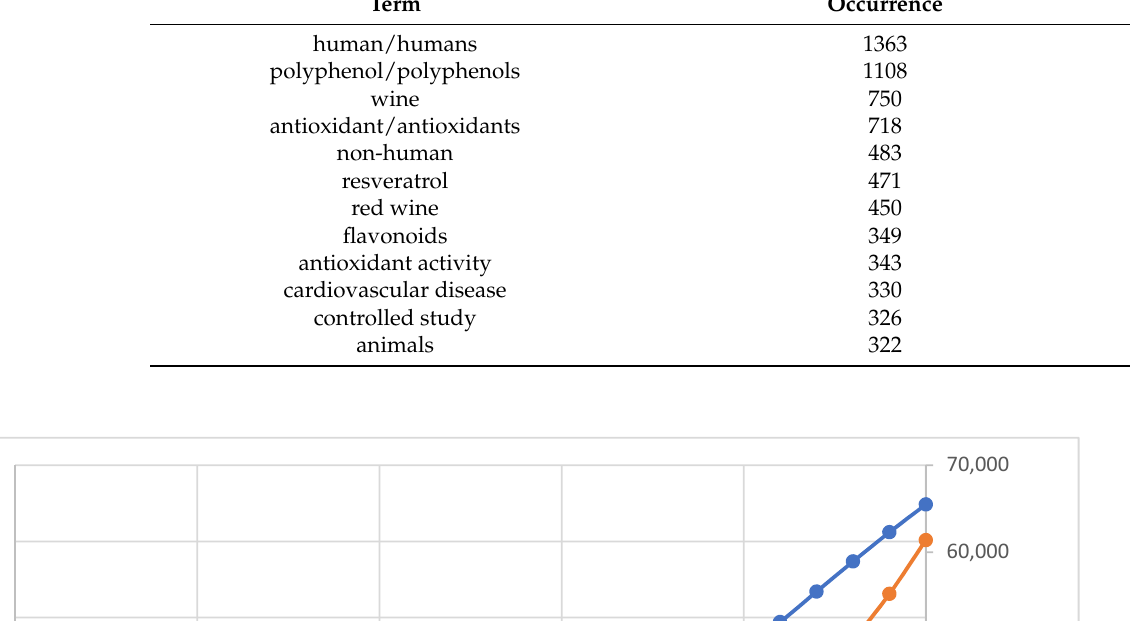
Table 1. The top-recurring terms on the relationships between wine polyphenol and health re- search. (Bibliometric data were extracted from the Scopus online database and elaborated by VOSviewer software).